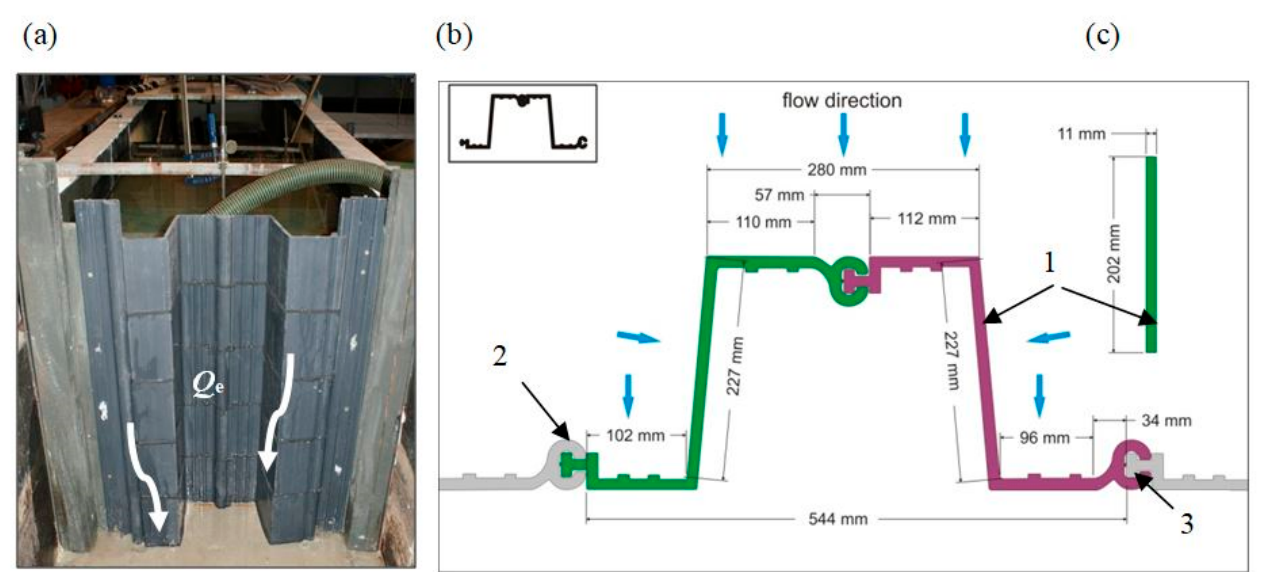
Figure 5. Measurement diagram of the Z compound regulator: ( a ) measuring station, ( b ) regulator mounting, ( c ) cross-section of the beam: 1—beam; 2—gib with female lock; 3—gib with male lock (photo by Z. Popek).